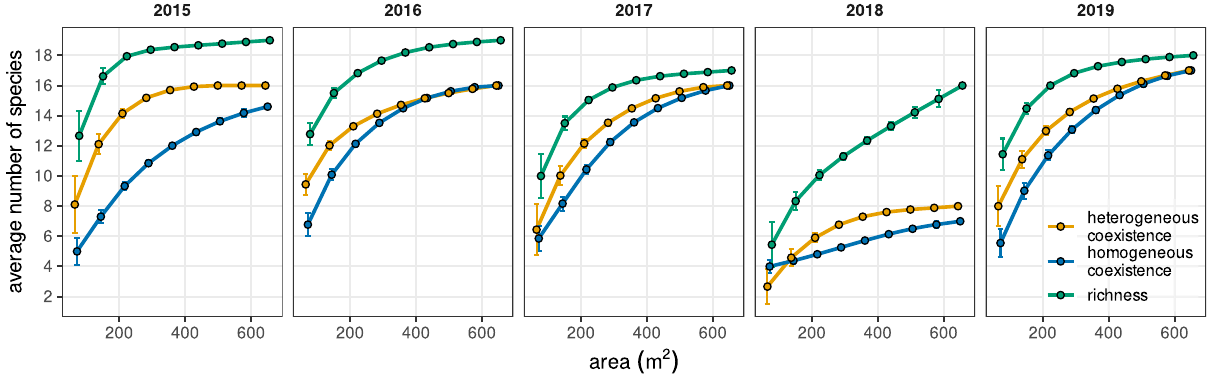
Fig. 2 Species – and coexistence – area relationships in a Mediterranean grassland community across 5 years. Points represent average values, and error bars represent the standard error of these averages. Note that curves describing the contribution of homogeneous and heterogeneous environments to the number of coexisting species (blue and yellow lines, respectively), and the curve describing the overall increase of species richness with area (green lines) remain similar across years, except for 2018. That particular year a series of strong rainfall events fl ooded our system during 2 months at the peak of the growing season (March – May). This extreme event represents a unique opportunity to document how coexistence – and species – area relationships are perturbed and how they can recover afterwards. Points represent average values over all combinations of plots resulting in a given area, as in Fig. 1. N = 9, 36, 84, 126, 126, 84, 36, 9, 1 combinations of plots, from the smallest to the biggest area,